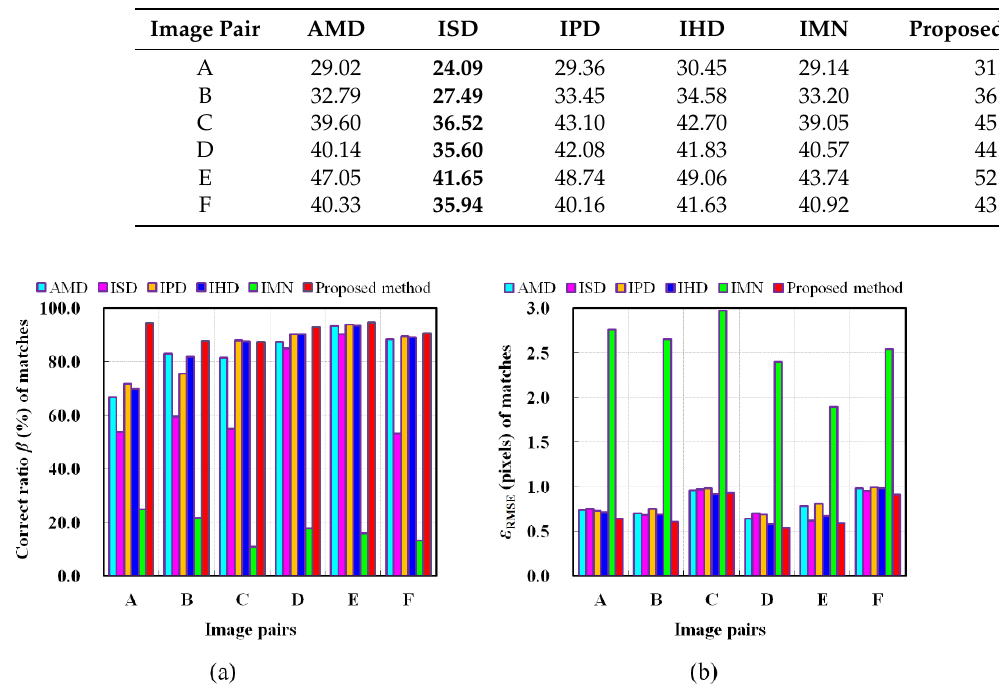
Figure 7. Comparison of different matching method in terms of the ( a ) correct ratio β (%) of matches (higher values are better) and ( b ) root mean square error ε RMSE (pixels) of matches (lower values are better).